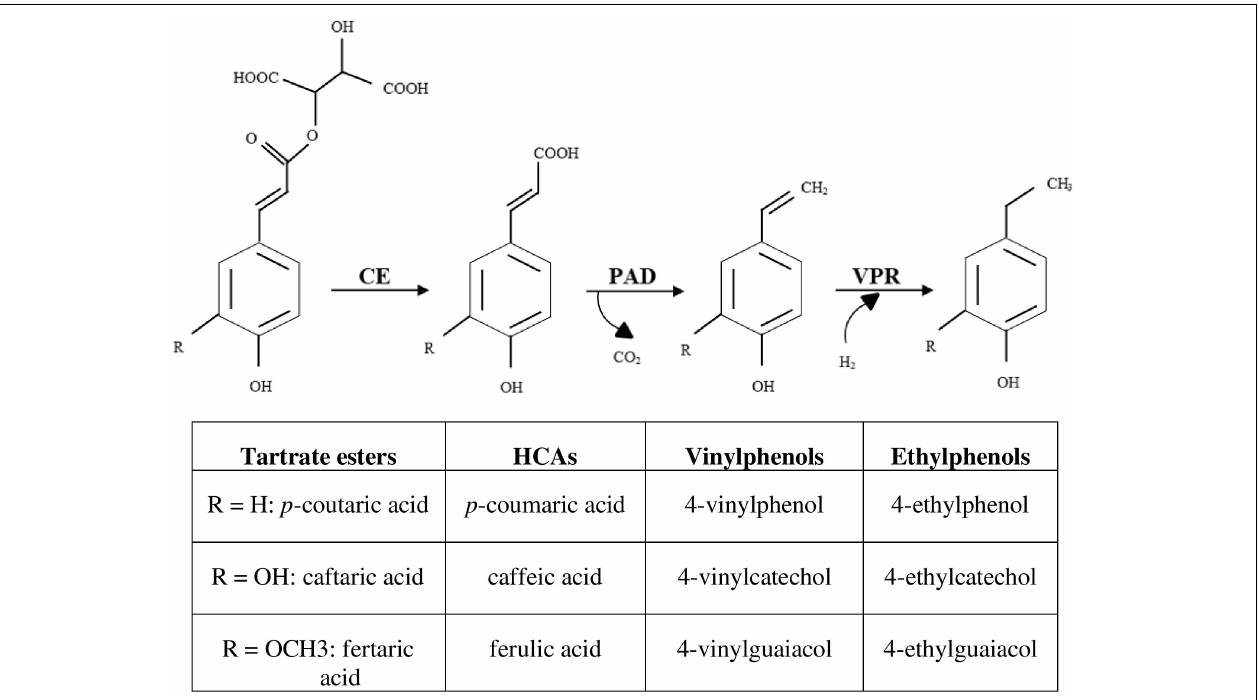
FIGURE 1 | Enzymatical activities linking the production of volatile phenols from its tartrate ester forms. CE, cinnamoyl esterase; PAD, phenolic acid decarboxylase; VPR, vinylphenol reductase; HCAs, hydroxycinnamic acids.